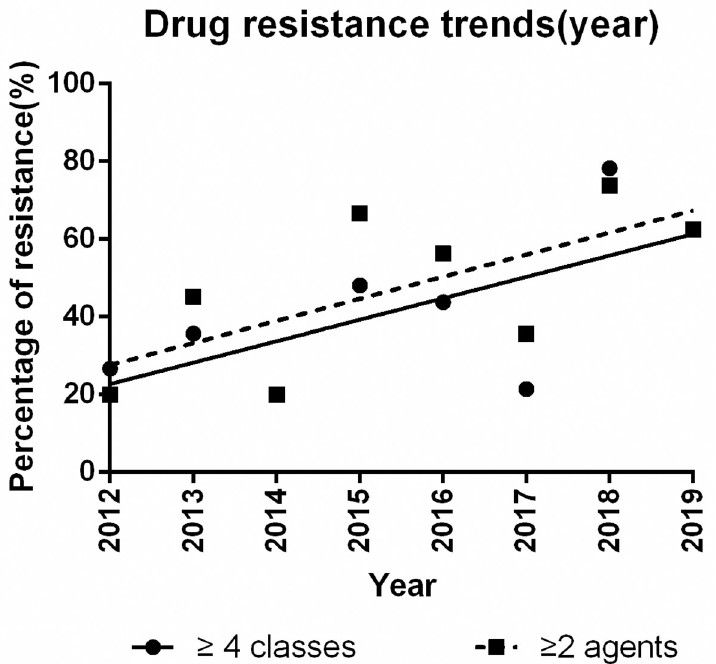
Fig 2. Drug resistance trends (resistant to � 4 CLSI classes and � 2 first-line agents) of 166 Salmonella isolates in Ningbo,2012–2019. The percentage of resistance (%) over the 8-year study period in Ningbo is shown in the line graph.